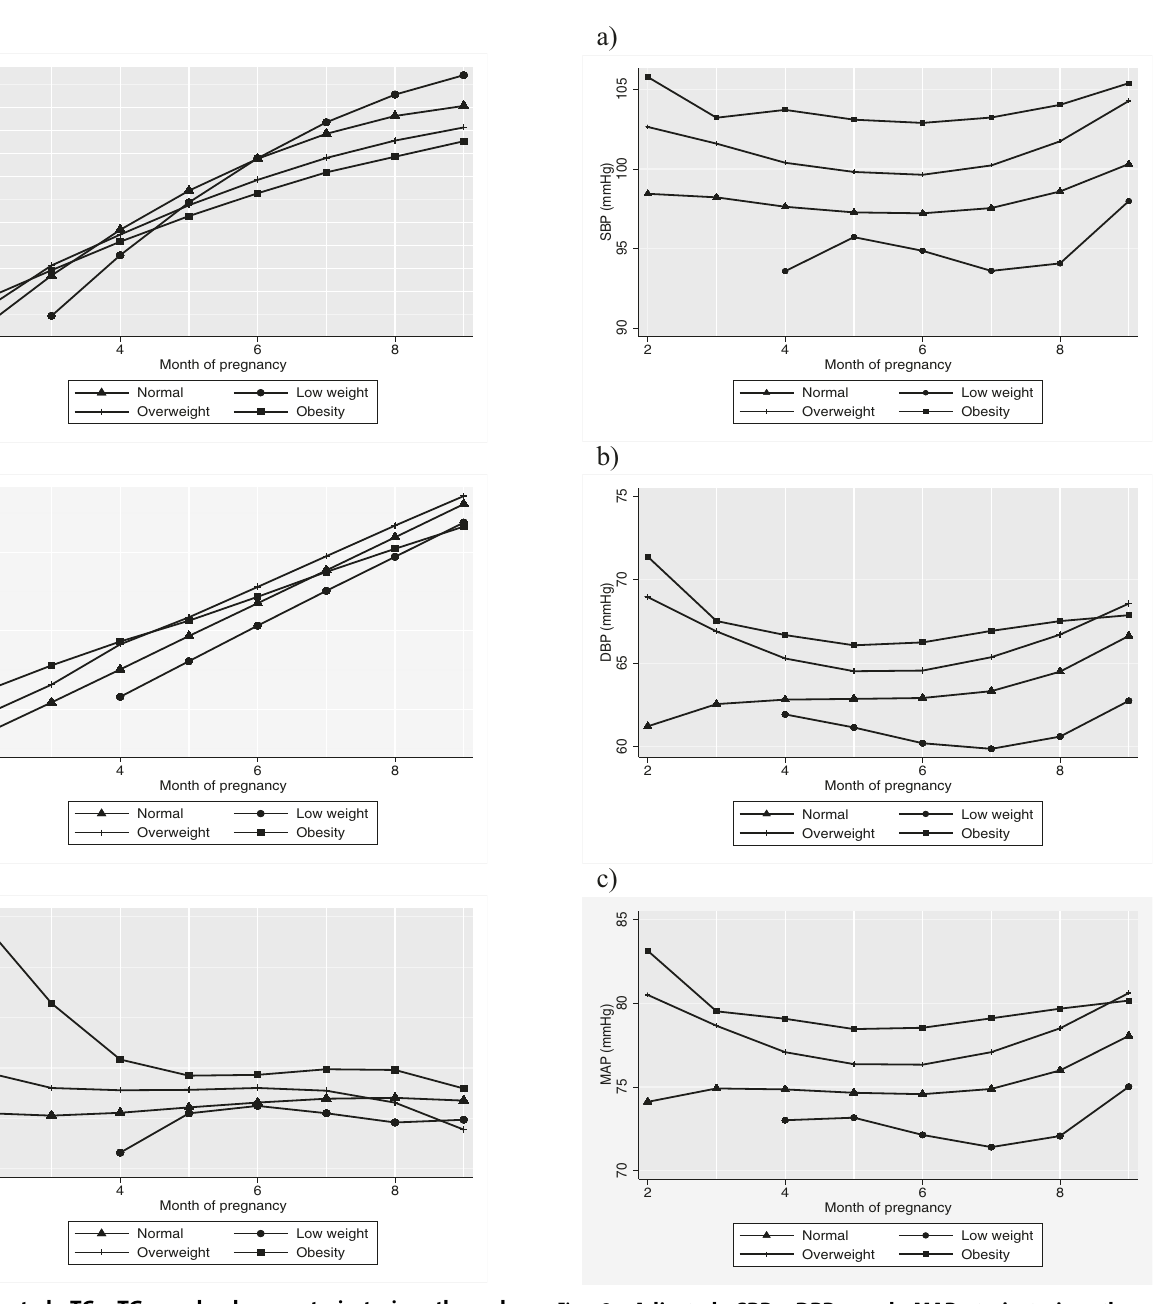
Fig. 2 Adjusted SBP, DBP, and MAP trajectories through pregnancy by pBMI groups. a Adjusted SBP trajectories by pBMI groups. b Adjusted DBP trajectories by pBMI groups. c Adjusted MAP trajectories by pBMI groups. pBMI pre-pregnancy body mass index, SBP systolic blood pressure, DBP diastolic blood pressure. Adjusted models controlled for: age, height, education, marital status, month of pregnancy parity and